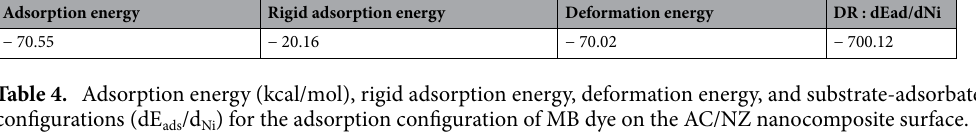
Adsorption energy Rigid adsorption energy Deformation energy DR :